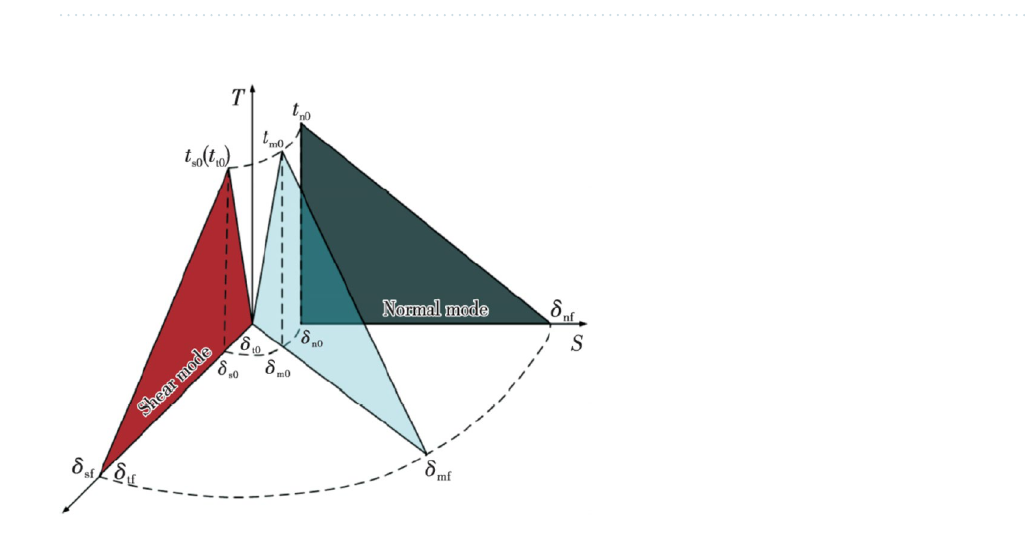
Figure 5. Mixed-mode cohesive traction